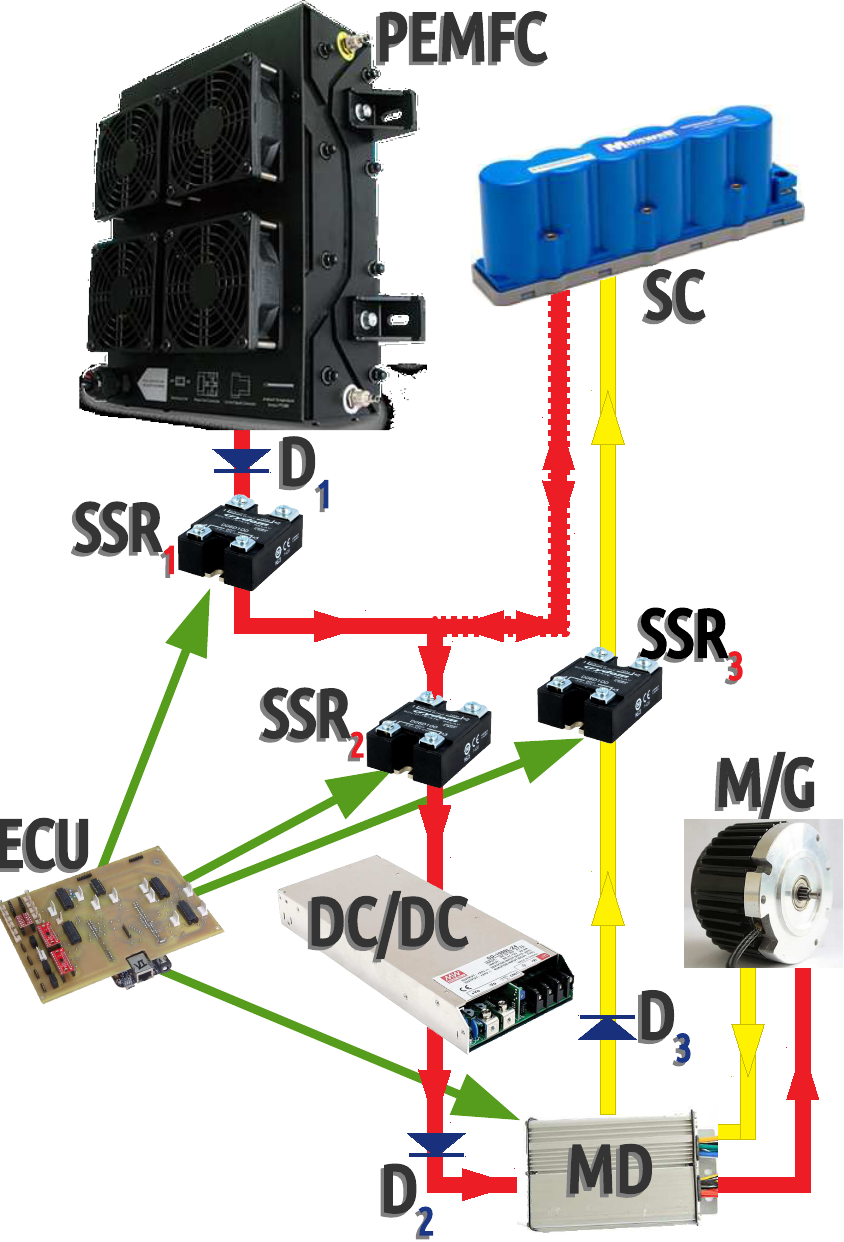
Figure 2. The architecture of the electrical system, where PEMFC is the Proton Exchange Membrane Fuel Cell, SC is the Super-Capacitors bank, DC/DC is the isolated buck-boost DC/DC converter, M/G is the electric Motor/Generator, MD is the Motor Driver, ECU is the Electronic Control Unit, SSRs are the Solid State Relays and Ds are the high power diodes. The red line indicates the energy flow during the normal mode operation. The dotted part of the red line indicates bidirectional flow of energy. The yellow line indicates the energy flow during the regenerative mode operation. The green line represents the communication between the ECU and the actuators of the